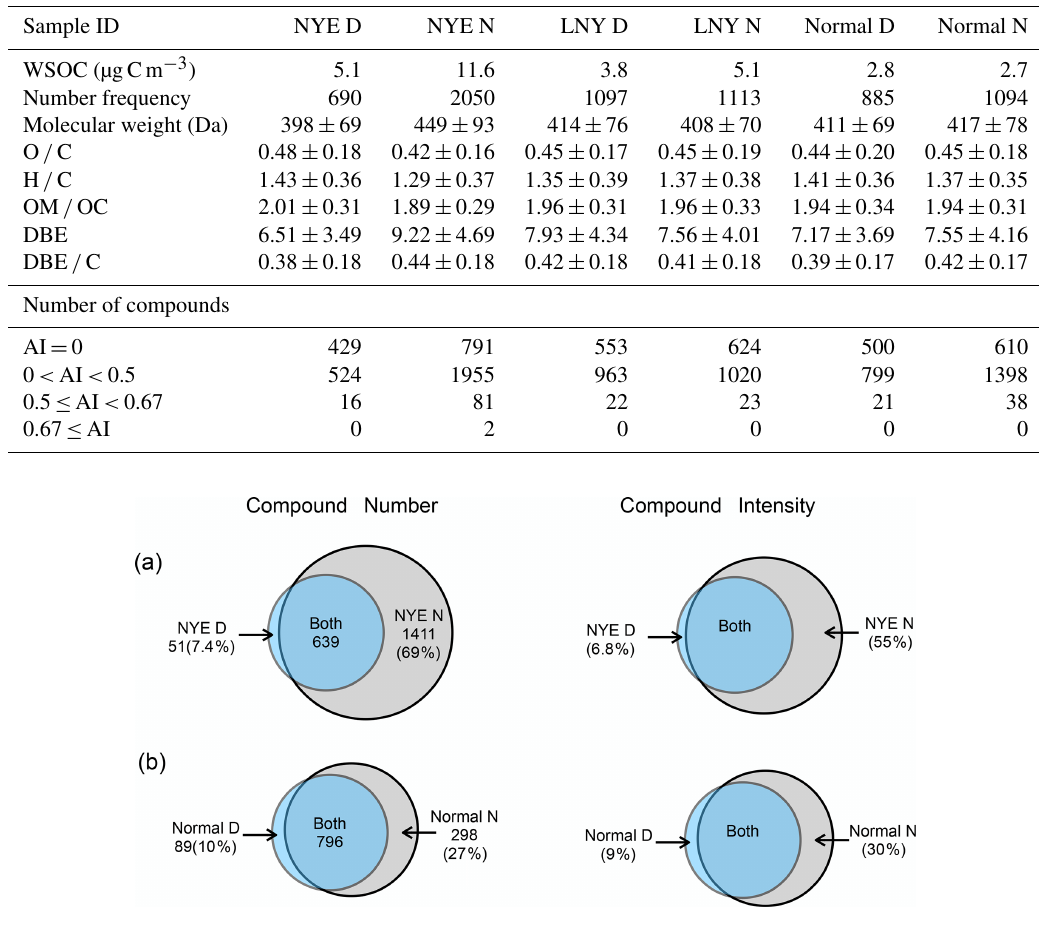
Figure 1. The compound number and intensity of nitrooxy OSs in (a) samples NYE D and NYE N and (b) samples normal D and normal N. The common compounds in both daytime and nighttime samples are denoted by “Both”, along with a number. The percentage numbers represent the proportion of the unique ones in the total nitrooxy OSs of each